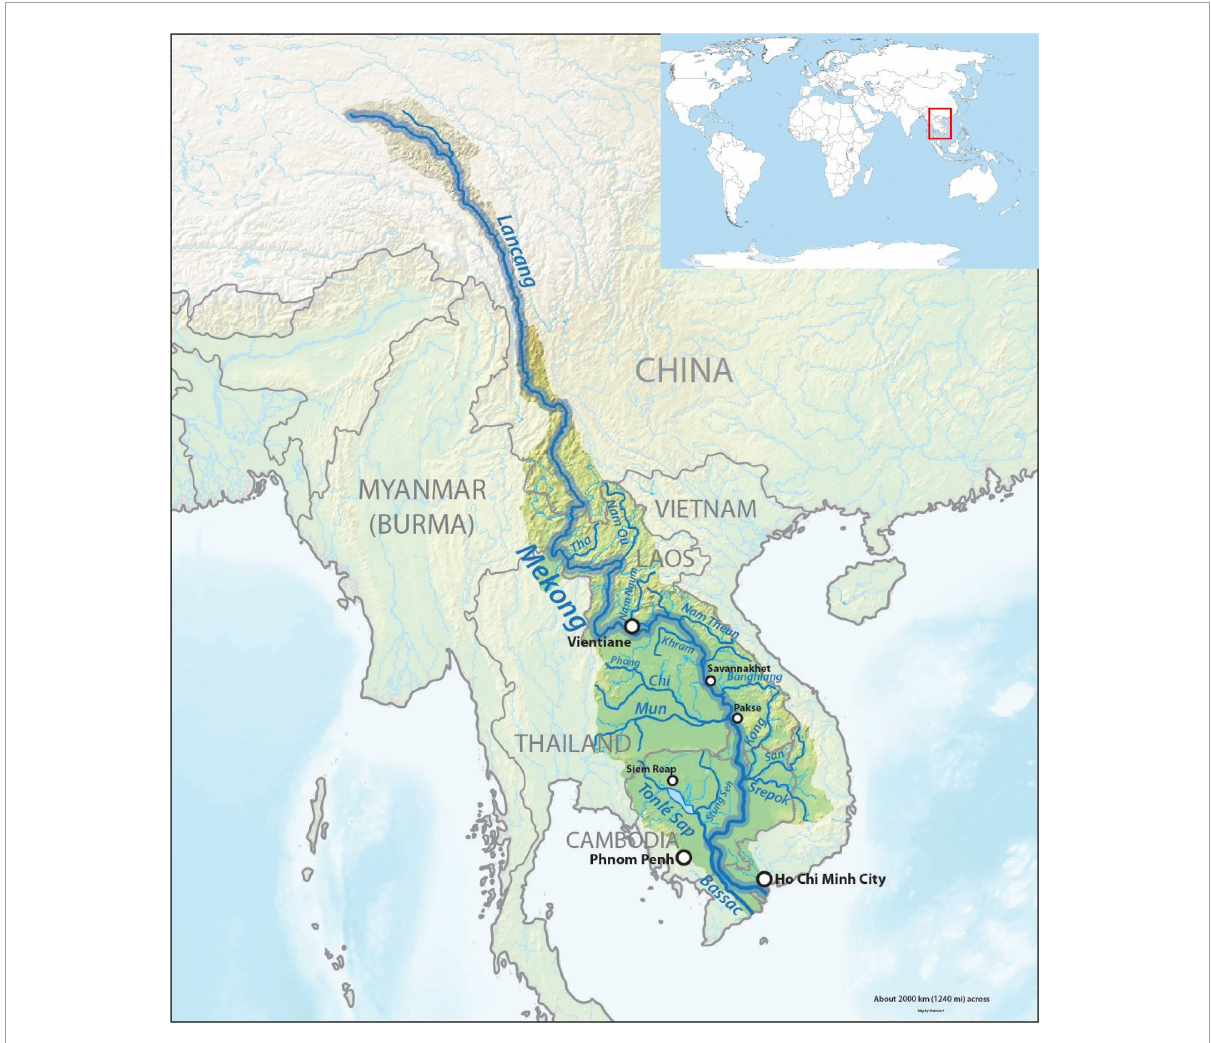
FIGURE1 The location of the research